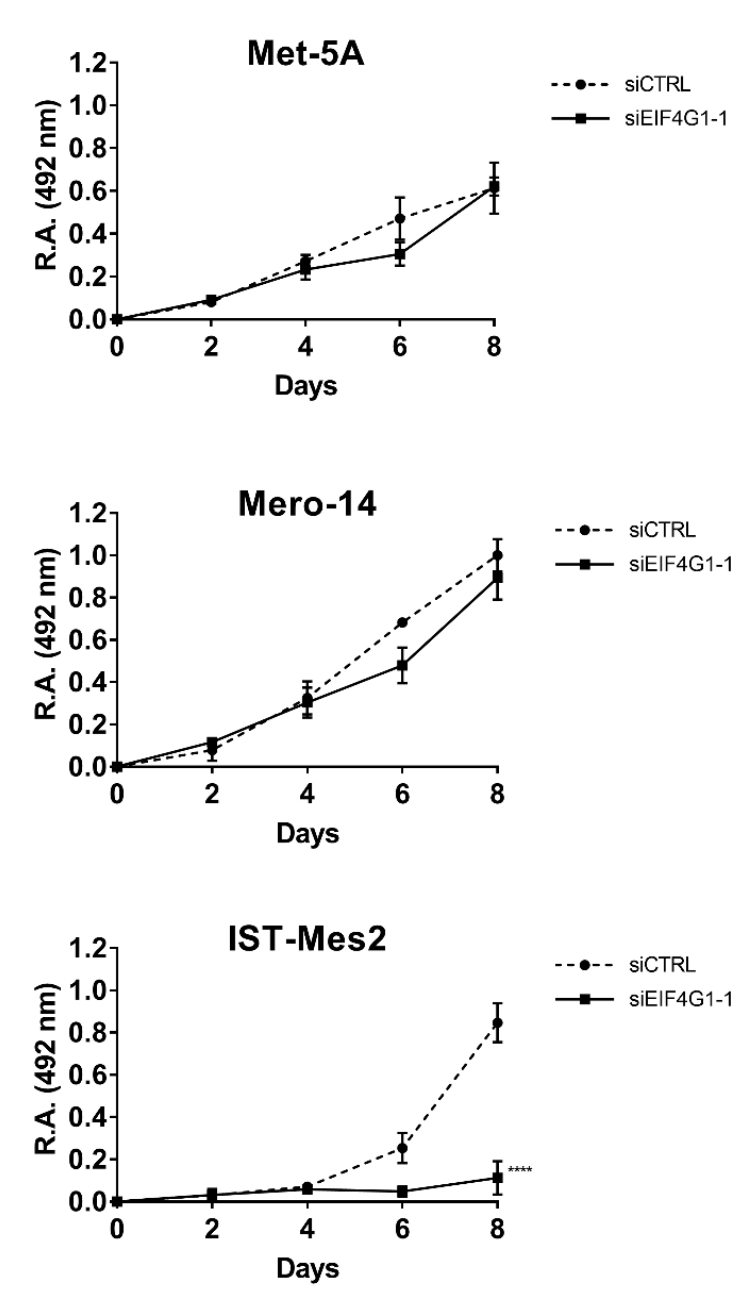
Figure 2. EIF4G1 silencing and cellular growth. Proliferation curves of MeT-5A and MPM cells, as Mero-14, and IST-Mes2. The acquisition of optical density at 492 nm (relative absorbance, (R.A.)), was made every two days after the day of transfection (that is Day 0) with siCTRL or siEIF4G1-1. Error bars are SEM from three independent experiments, each performed in triplicate. Statistical significance is indicated by asterisk (*), where * p < 0.05; ** p < 0.01; *** p < 0.001, **** p < 0.0001 compared to control treatment.